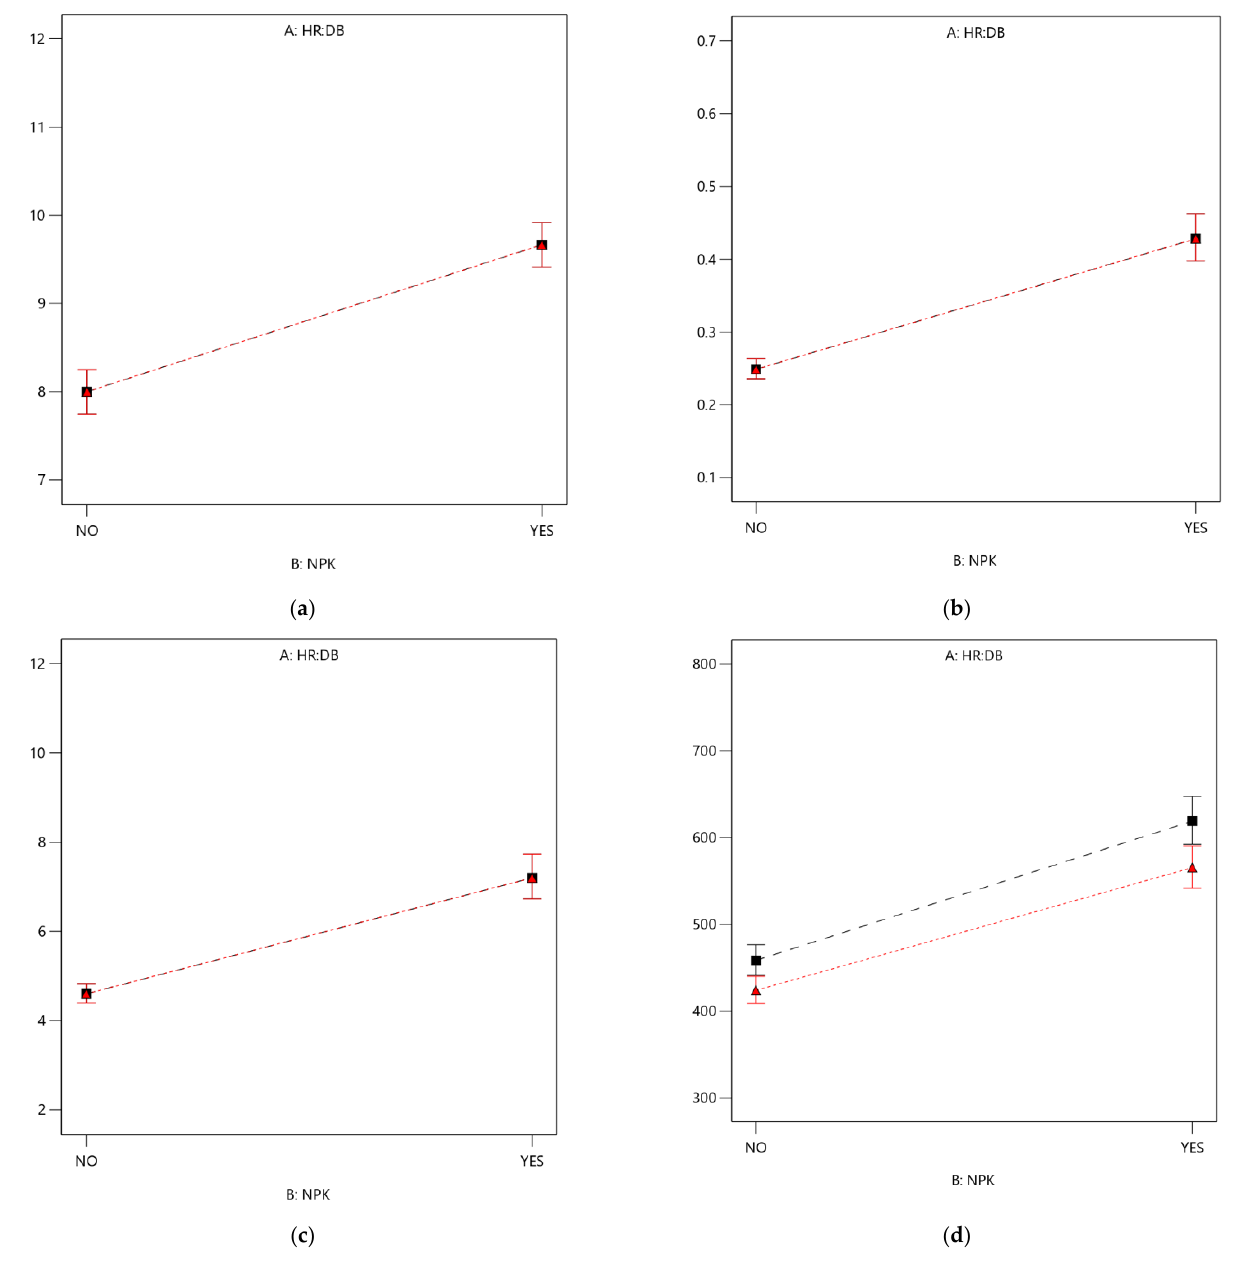
Figure 8. Interaction plots of different responses: in black color, the interaction lines related to 1HR:3DB; in red color, the interaction lines related to 3HR:1DB: ( a ) NoL; ( b ) TFM; ( c ) LAI; ( d ) SLA. Error bars indicate the standard deviation on the average values. LAI: Leaf Area Index, NoL: Number of Leaves, SLA: Specific Leaf Area, TFM: Total Fresh